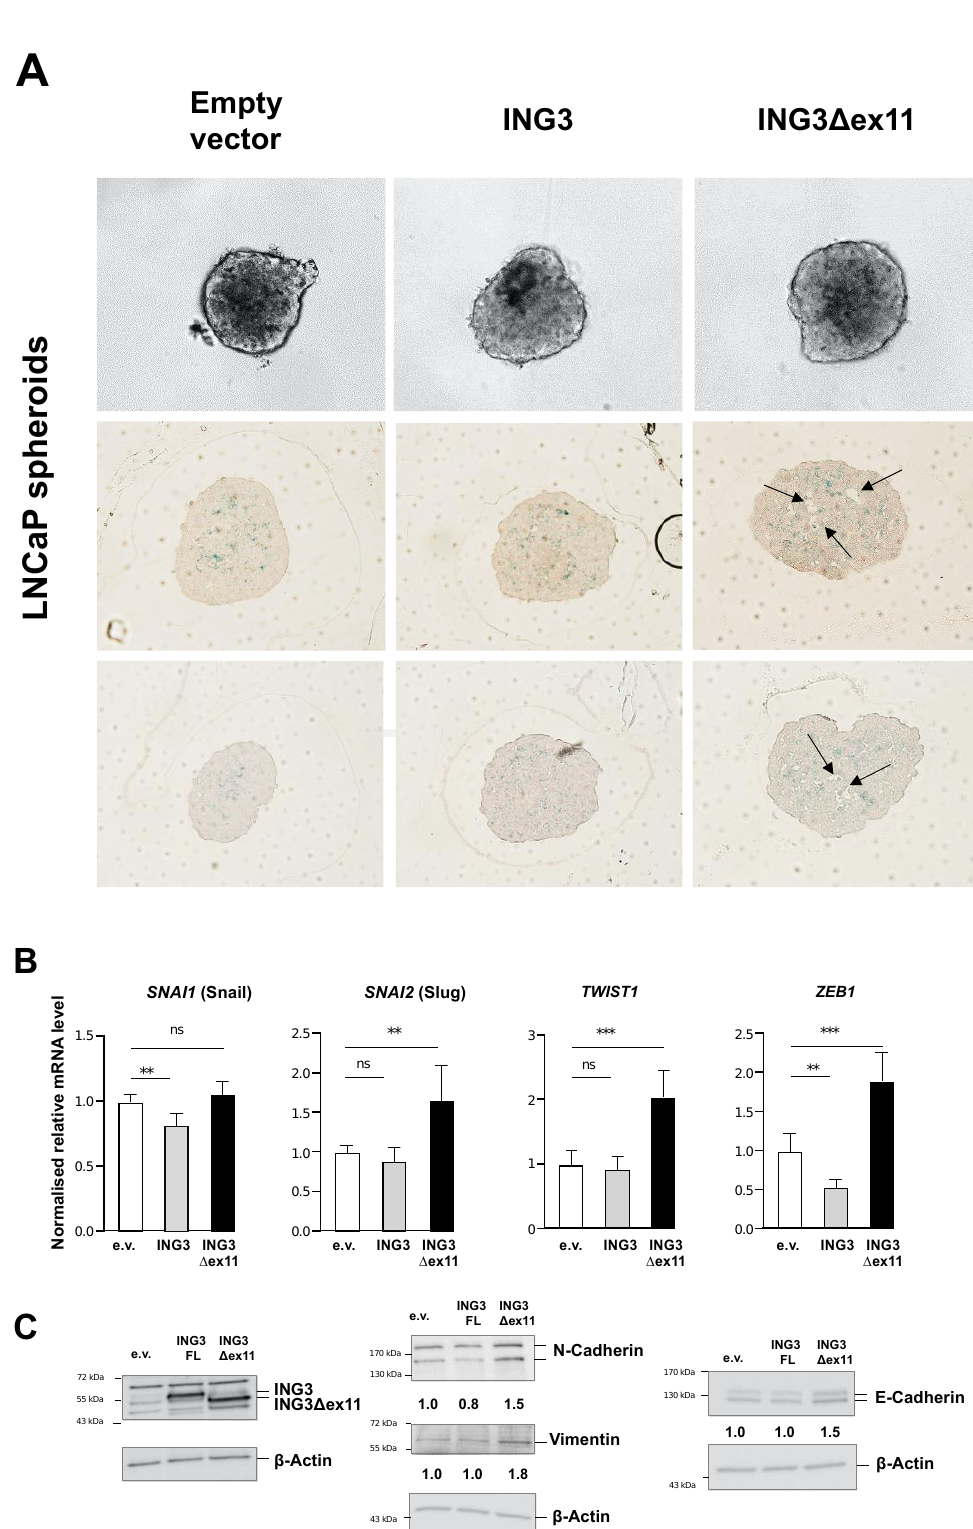
Figure 3. Formation of lumen and pore-like structures in ING3∆ex11 overexpressing LNCaP-derived tumour spheroids. ( A ) LNCaP spheroids were generated and sliced. Arrows indicate lumen and pore-like structures within spheroids. ( B ) Analysis of mRNA levels of key EMT regulators by qRT-PCR and ( C ) epithelial and mesenchymal markers at protein level by Western blot. p values: p < 0.05 (*); p < 0.01 (**); p <0.001 (***); ns: not significant; e.v., empty vector control.